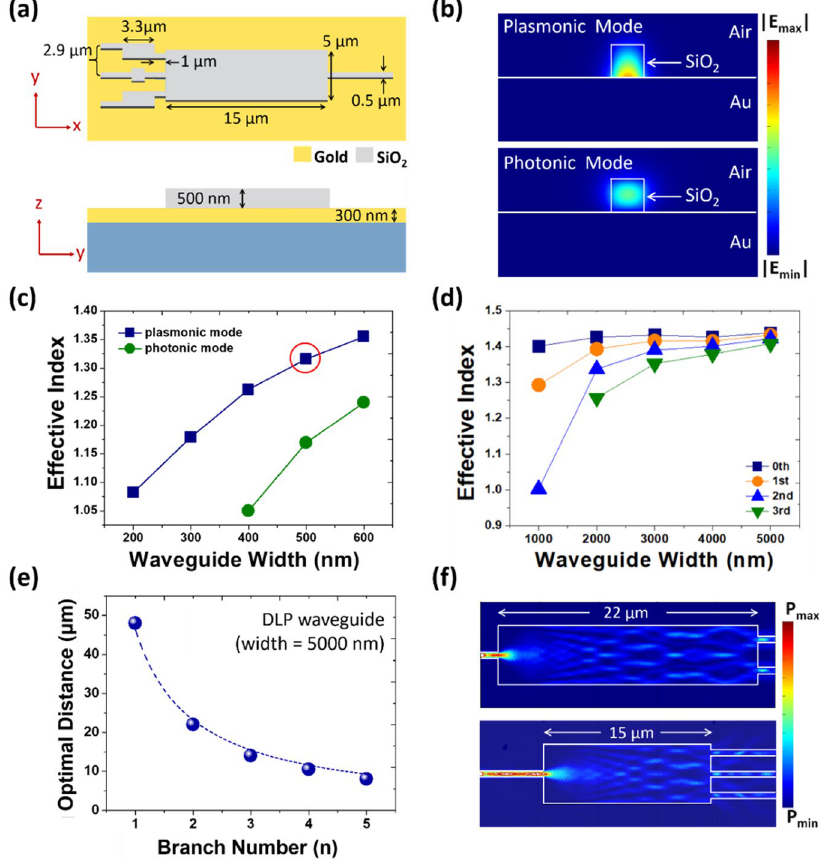
Figure 2. ( a ) Dimension of the plasmonic XNOR gate in the x–y (top panel) and y–z plane (bottom panel). Gold and SiO 2 are chosen as the material for the substrate and the dielectric waveguide, respectively. ( b ) Simulated cross-sectional electric field mode profile of the fundamental plasmonic (top panel) and photonic (bottom panel) guided mode in a 500 × 500 nm 2 SiO 2 dielectric channel on a gold substrate. White solid lines mark the boundaries of the dielectric waveguide and the surface of the gold substrate. ( c ) Simulated effective indices of the fundamental plasmonic (navy blue squares) and photonic mode (dark green dots) as functions of the width of the SiO 2 dielectric waveguide between 200 and 600 nm. ( d ) Same plot as ( c ) with only the indices of fundamental and high-order plasmonic guided modes with respect to the waveguide width over the extended range of 1000–5000 nm. Apart from the fundamental plasmonic mode (navy blue squares), the first- order (orange dots), second-order (blue triangles), and third-order (green inverted triangles) plasmonic modes can also exist in the DLP waveguide. ( e ) The optimal distance for n-branched power splitting plotted versus the number of branches, n. Dots are data points obtained from COMSOL simulation and the dashed curve is obtained from fitting the simulated data with Eq. (1). ( f ) Simulated spatial distribution of optical power flow for the cases of two- (top panel) and three-branched power splitting (bottom panel) cases. The input on the left side of the image is a single SiO 2 channel (cross-section: 500 × 500 nm 2 ) on a gold substrate and the following MMI section has the same height but a much larger width of 5000 nm with lengths optimized for two- and three- branched